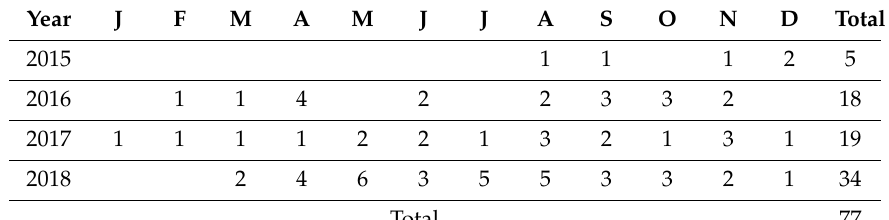
Table 3. Number of Sentinel-2 images of the study area obtained by month and year.